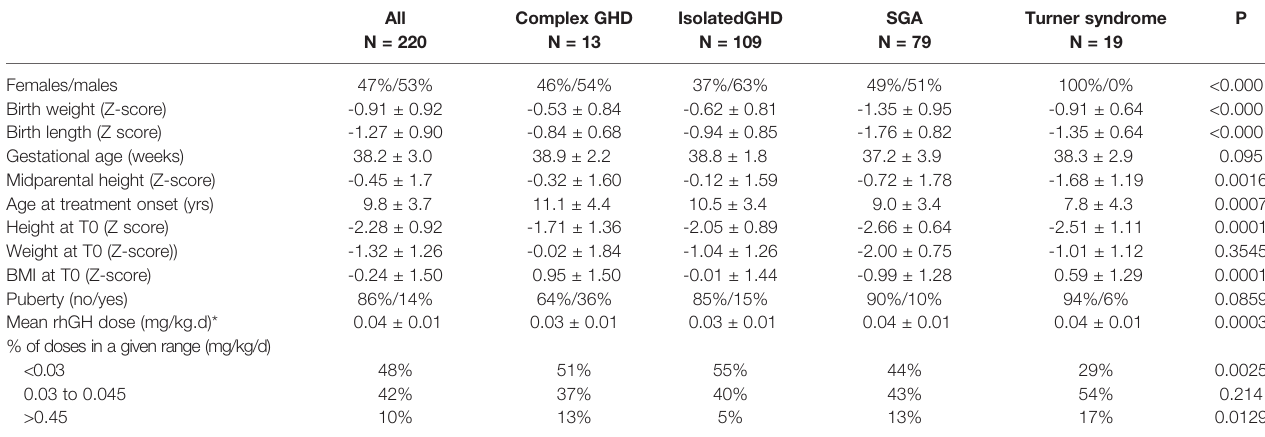
TABLE 1 | Clinical characteristics of the study